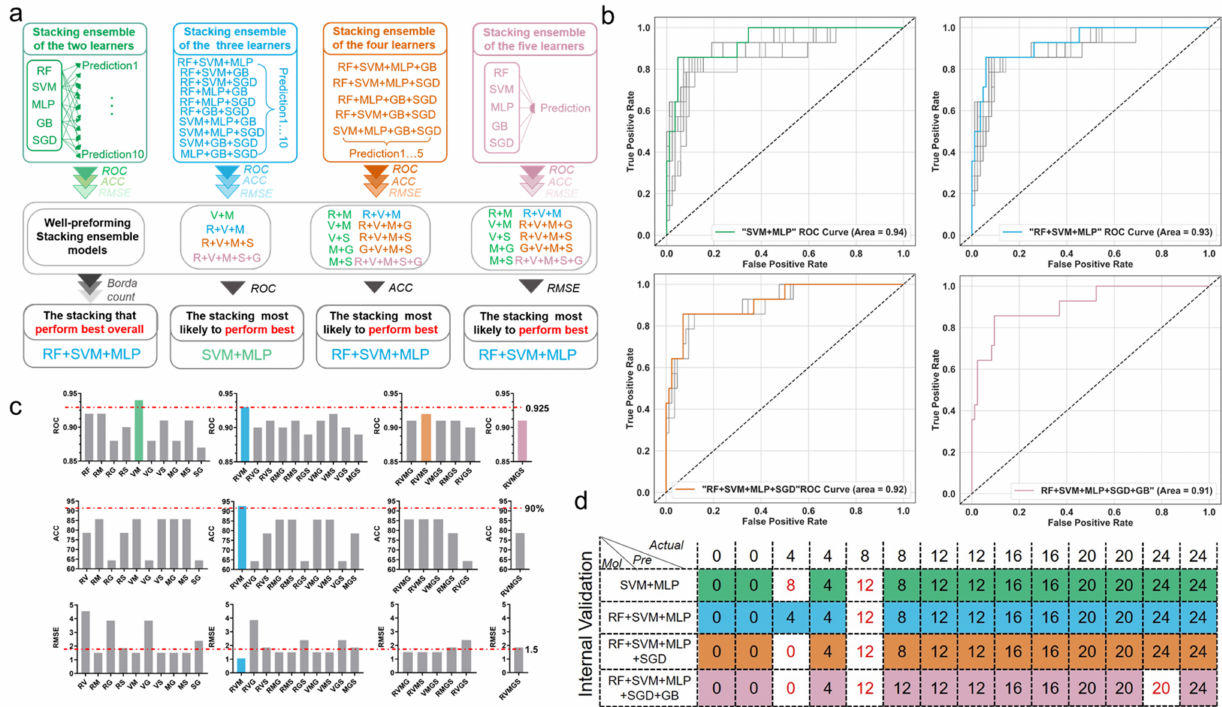
Figure 4. The comparison of 26 stacking models. ( a ) The workflow of the assessment of the stacking ensembles. ( b ) The AUROC of stacking models. The top left panel represents the 10 stacking models combing the two basic models with the well-performing model indicated with a colored line. Similarly, the top right, bottom left, and bottom right represent stacking models combing three, four, and five basic models, respectively. ( c ) Performances of 26 stacking models in terms of AUROC, accuracy, and RMSE. The horizontal coordinate represents different stacking models combing different basic learners. ( d ) Confusion matrix of best-performance stacking models. Abbreviations: RF: